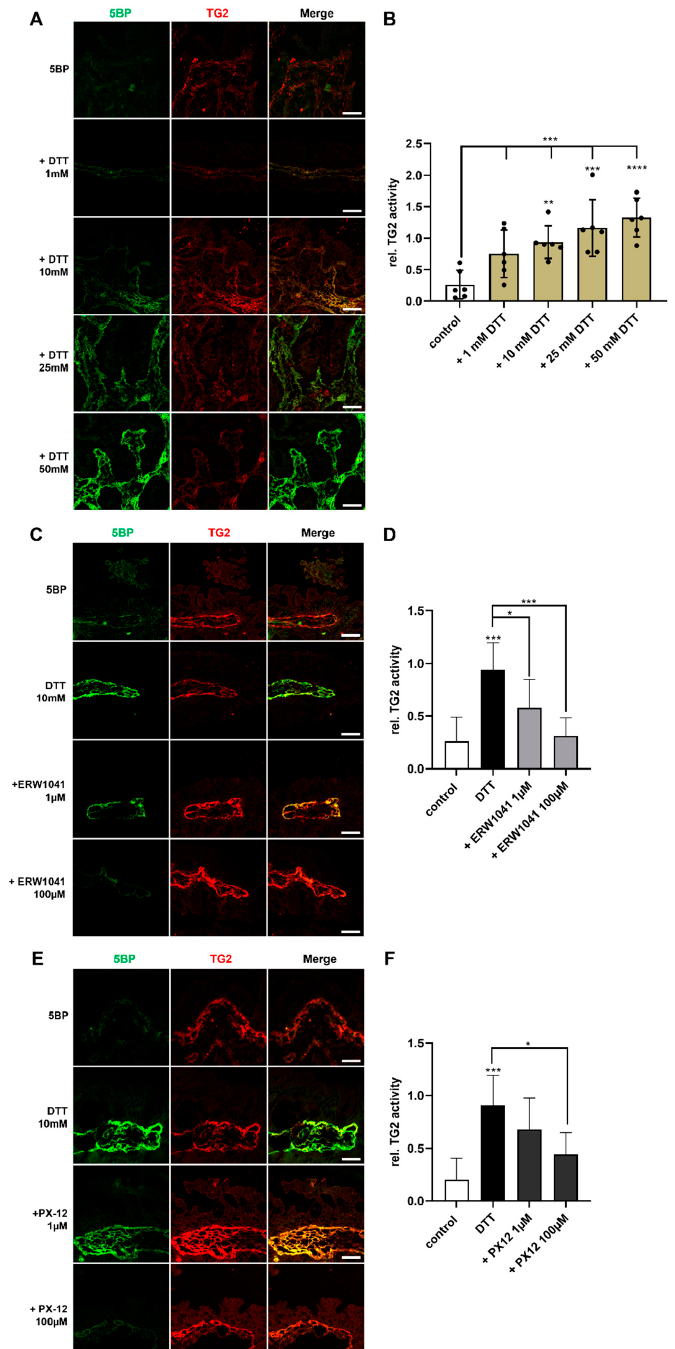
Figure 2. PX-12 inhibits TG2 in the intestinal lamina propria. ( A ) Unfixed cryosections (400 nm) of duodenal biopsies were incubated with 5BP in the presence of increasing concentrations of DTT. Increasing amounts of DTT activate TG2 in the lamina propria. ( B ) TG2-activity (green) was normalized against TG2-expression (red) and quantified using ImageJ. Higher amounts of DTT led to increased TG2 activity. n = 6; 5 images per patient were quantified. ( C – F ) Cryosections were treated with ERW1041 and PX-12 prior to the incubation with 5BP. Both inhibitors significantly reduced TG2 activity in the lamina propria. n = 6; 5 images per patient were quantified. All data are shown as mean ± SD. Statistical significance was tested with one-way ANOVA and Dunnett’s multiple comparison test. * p < 0.05; ** p < 0.01; *** p < 0.001; **** p < 0.0001. Scale bars: 20 µ